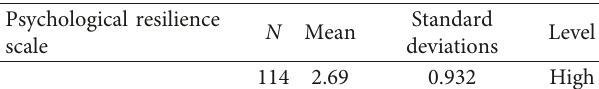
Table 3: Correlation coefficients between the score of each item of the cognitive failure scale and the overall score of the scale.